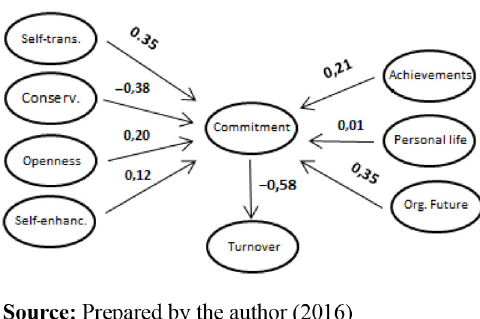
Figure 3. Standardized pathway estimates of the structural model